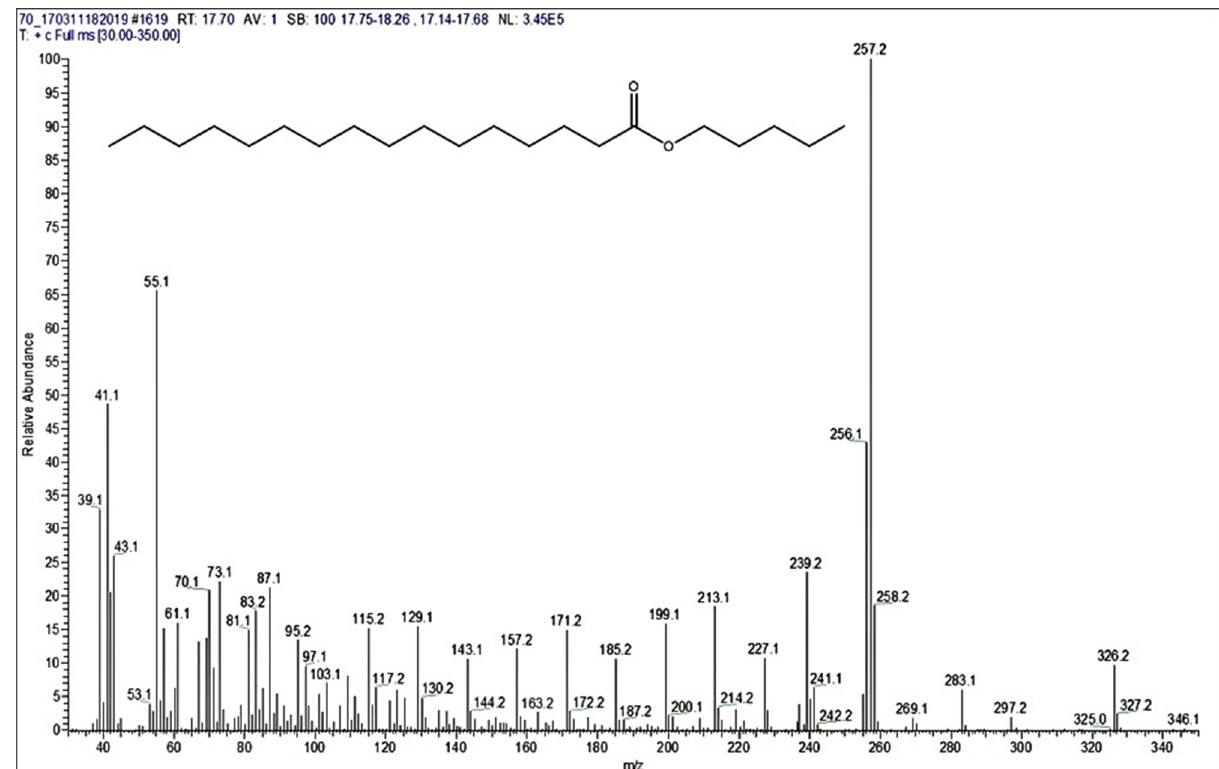
Figure 4. The mass spectrum of the ester, corresponding to the peak separated on the GC column at 19.15 min retention time (M = 348 g/mol), in the case of B3 bioester.